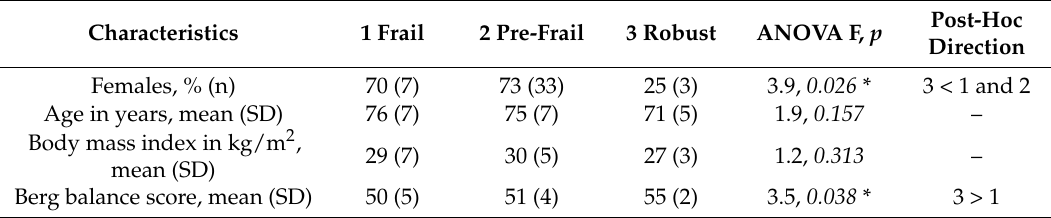
Table 1. Participants’ characteristics by frailty